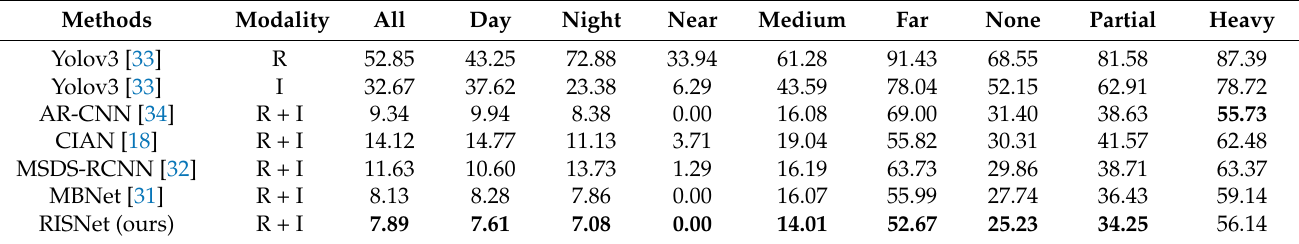
Table 2. Evaluations on the KAIST dataset under all nine test subsets (MR − 2 ). The best MR − 2 indicators are generally